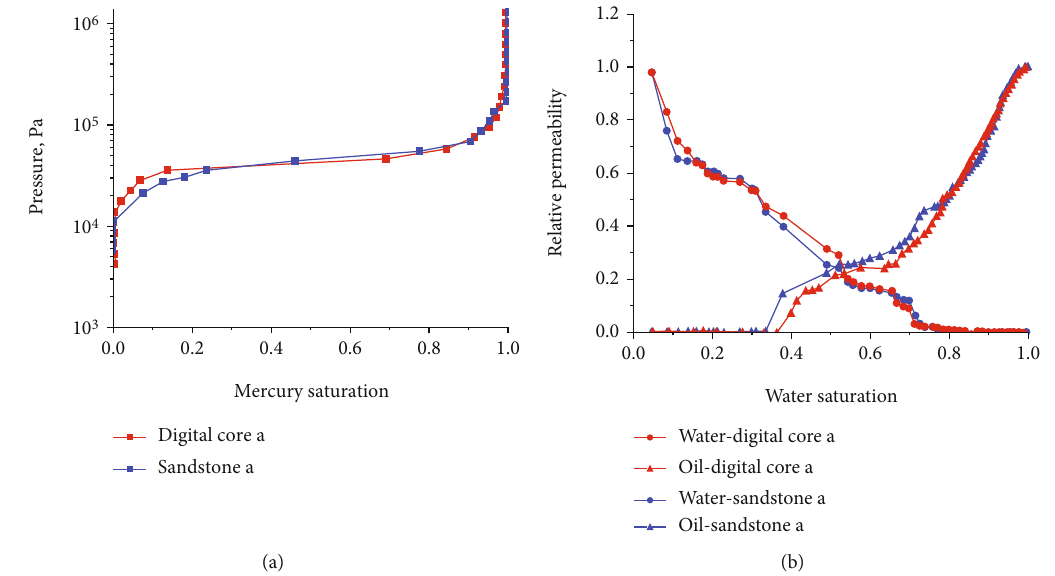
Figure 20: (a) Mercury injection and (b) oil-water two-phase fl ow simulation of digital core a and sandstone a.